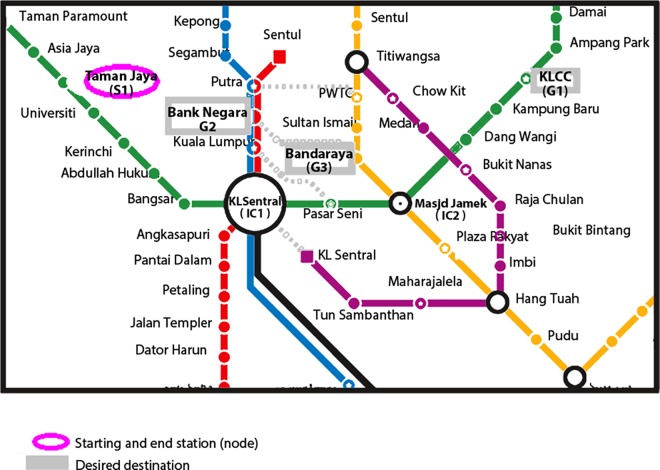
Map of case 2 desired stations in the network.